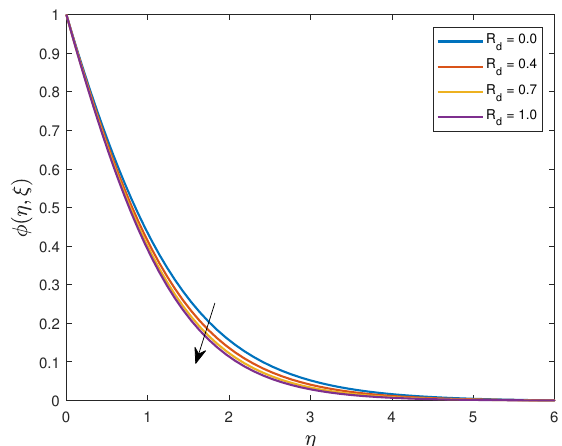
Figure 24. The influence of R d on fluid